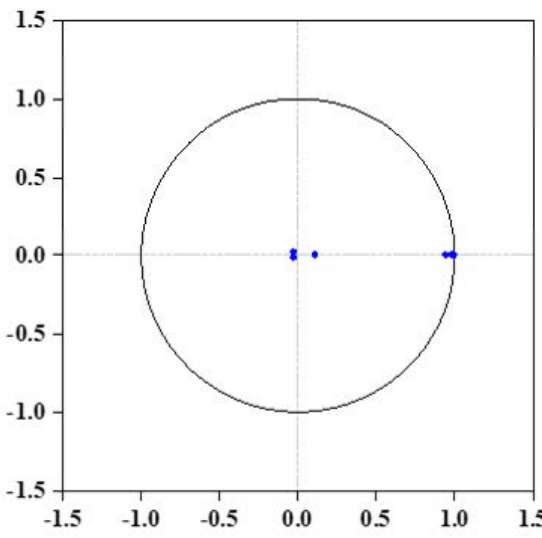
Figure 4. Inverse roots of A.R. characteristic